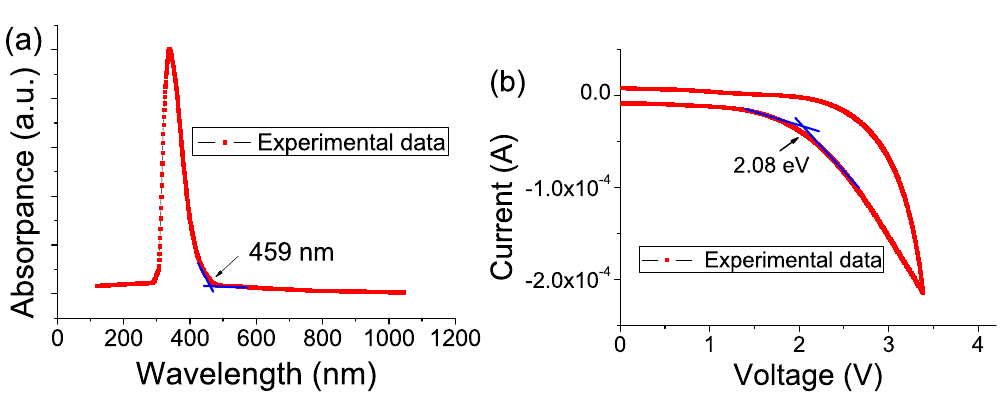
Figure 11. ( a ) UV-vis absorption spectra of GO film. ( b ) C-V sweeps of the GO film.